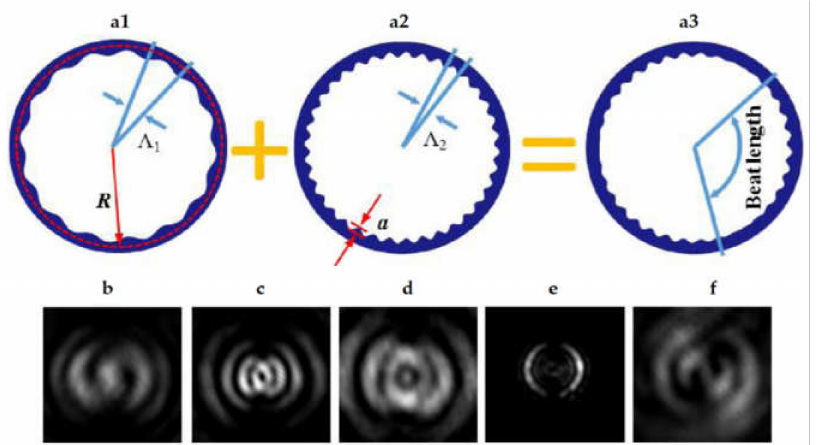
Figure 8. ( a1 , a2 ) Schematic of two single grating (with period of Λ 1 and Λ 2 , respectively) super- imposed into multiple-beat modulated device [151]. An unfolded view of resulting the three beats device ( a3 ) [151]. The far-field patterns of the two-beat grating device: ( b ) 1508.1 nm, topological charges combination +1 and − 1; ( c ) 1518.9 nm, topological charges combination 0 and − 2; and ( d ) 1530 nm, topological charges combination − 3 and − 1 [151]. The near-field pattern is showing in ( e ), and the well-defined spiral interference fringe existed at appropriate locations is showing in ( f )